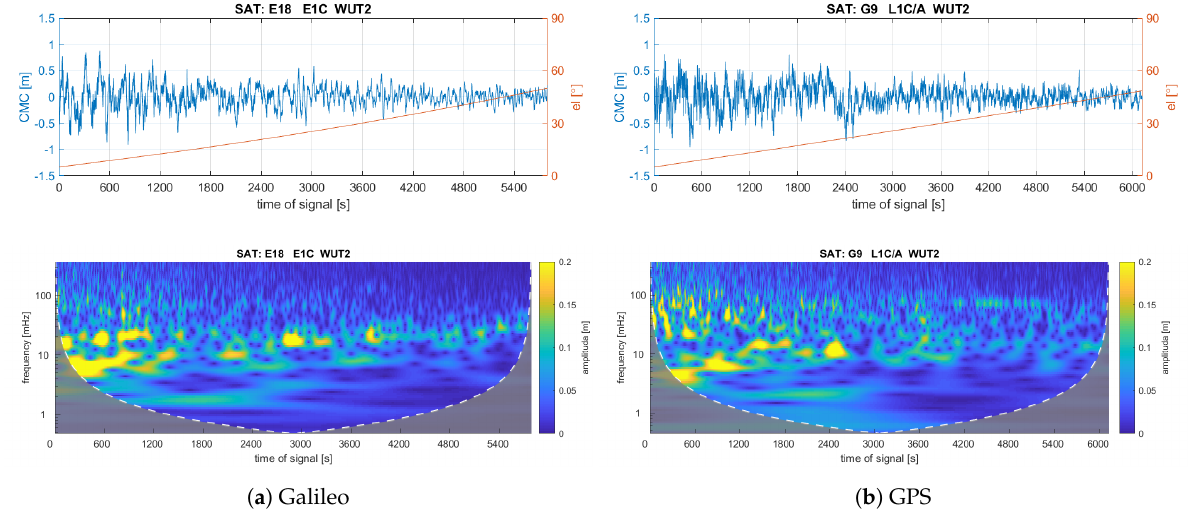
Figure 10. CMC observables and scalograms for ( a ) Galileo E18 and ( b ) GPS G09 satellites at the WUT2 site.